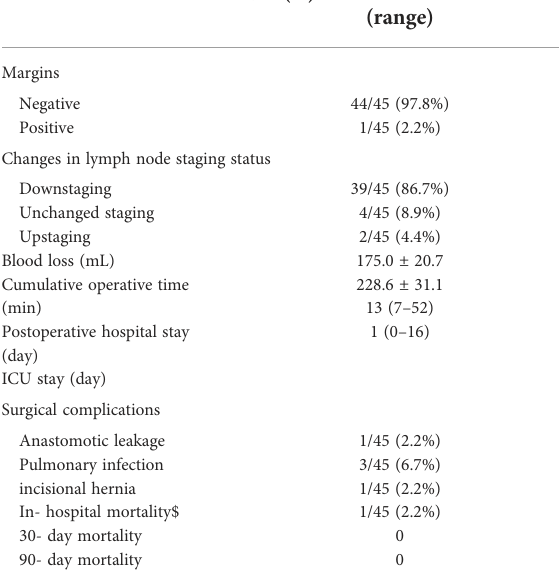
TABLE 3 Surgical outcomes (N=45